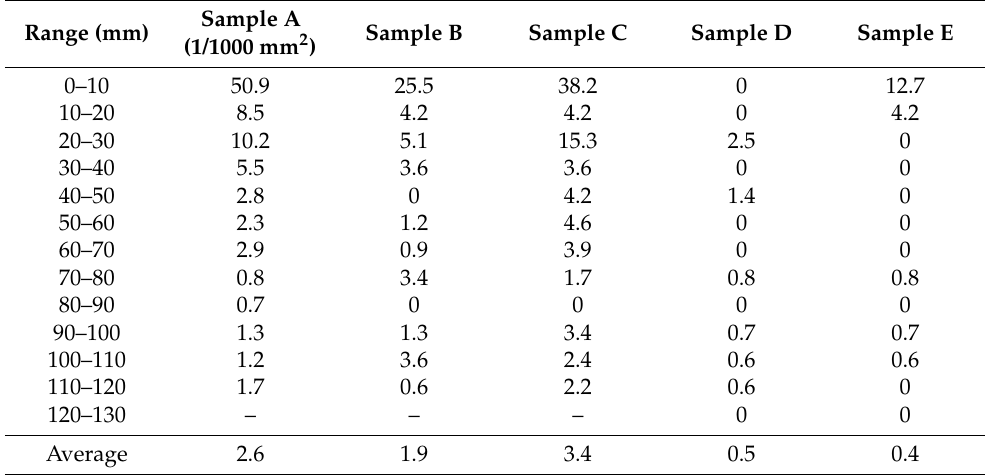
Table 2. The density for radial distribution of FPDs etched by